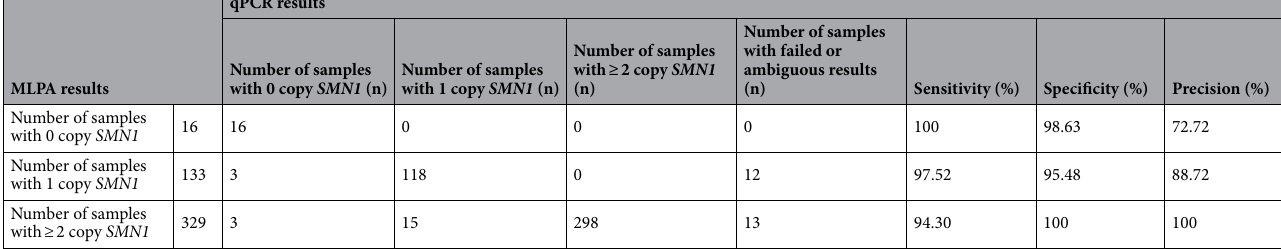
Table 1. The performance of qPCR method for SMN1 copy number detection.